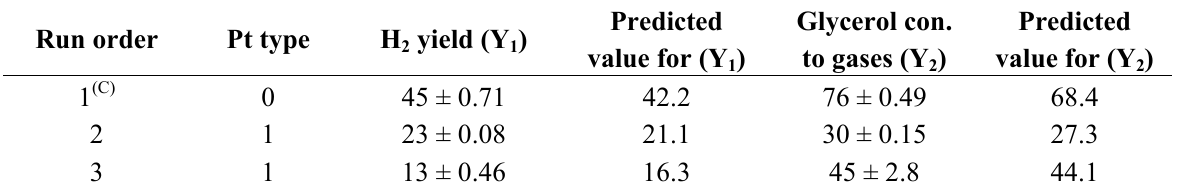
Table 3. The results data for the independent variables obtained from the designed experiments. Run